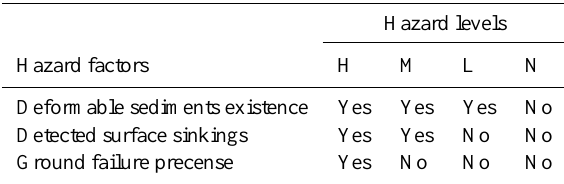
searching for evidences of pre-subsidence cracks should be enough.